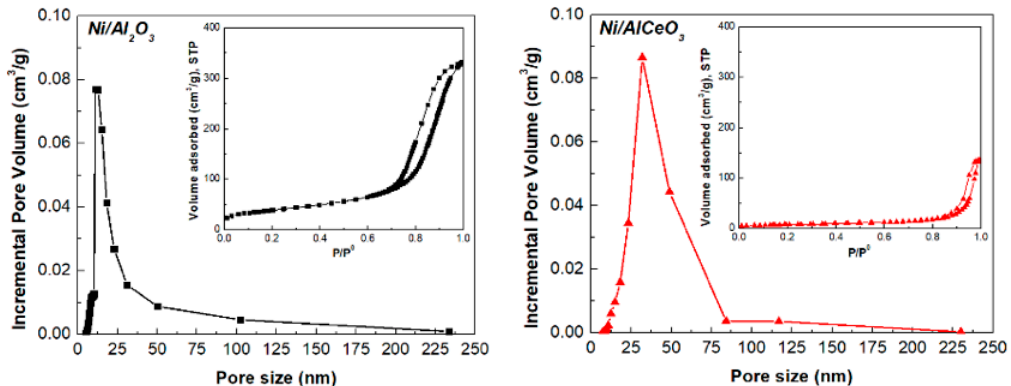
Figure 2. Pore size distribution and N 2 adsorption-desorption isotherms (inset) of the reduced Ni/Al 2 O 3 and Ni/AlCeO 3 catalysts.